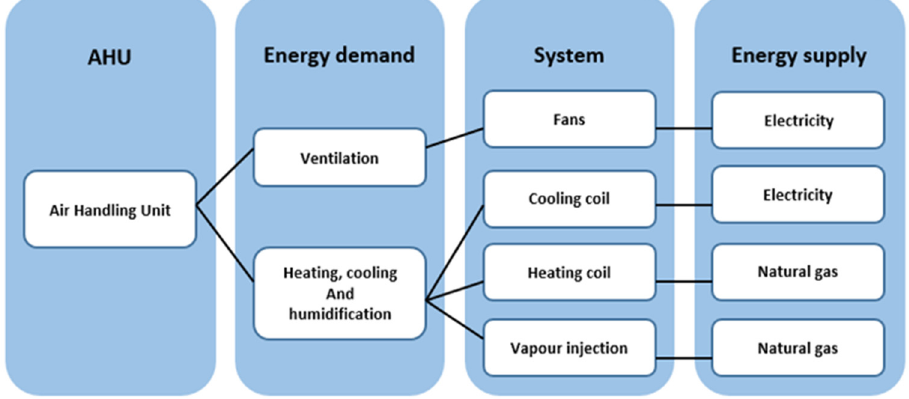
Figure 6. Systems and Energy Supply Affected by the HVAC Regulation and Control of an OR.